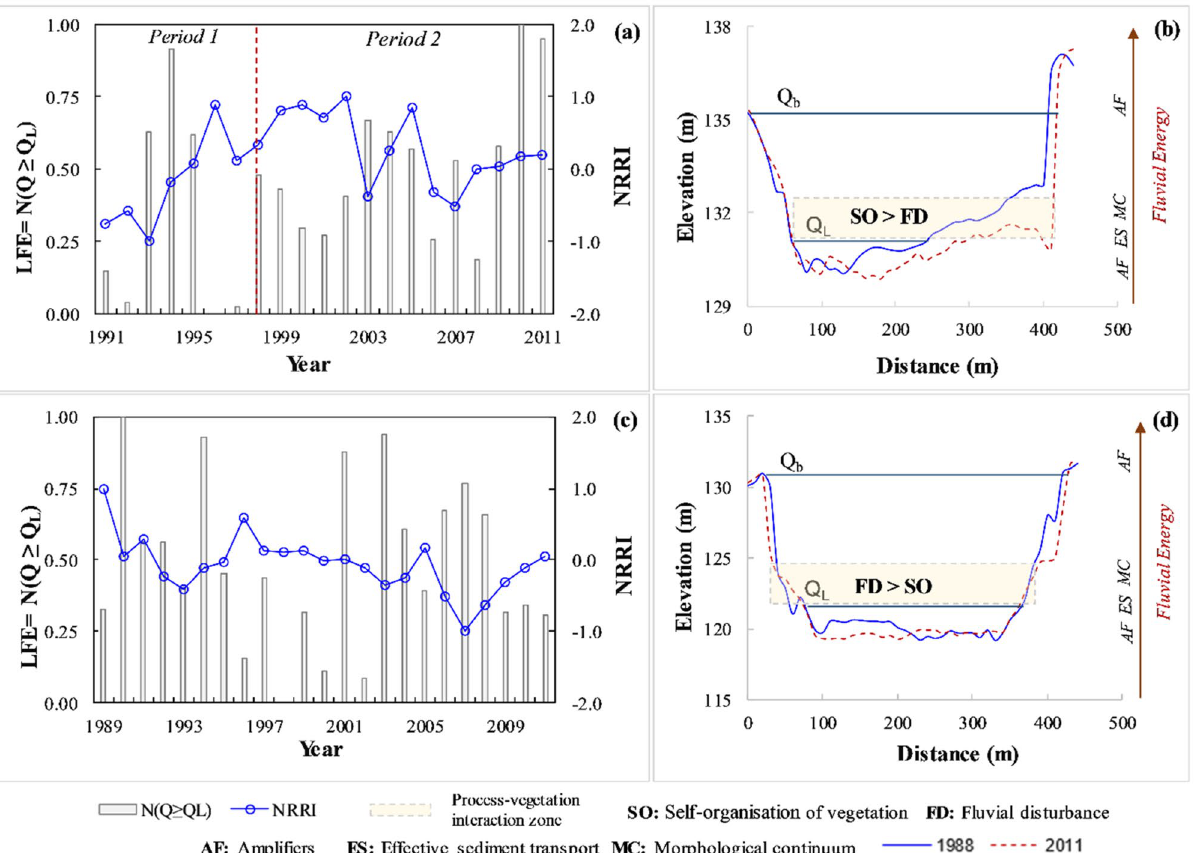
Figure 7. Relation between normalised low-flow exceedance (LFE = N(Q ≥ Q L )) and normalized river recovery index (NRRI) along ( a ) the Ong and ( c ) the Tel Rivers. The conceptual diagrams for the hierarchy of energy dissipation in macrochannel systems and dominant variables for the hotspot-zone of ecosystem engineering are also presented along ( b ) the Ong and ( d ) the Tel